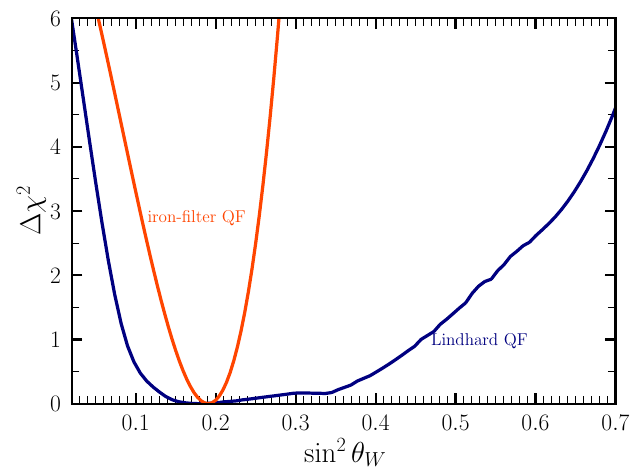
Figure 2 . ∆ χ 2 profiles for sin 2 θ W for the two QFs considered [modified Lindhard QF, eq. (3.3), and iron-filter QF as given in the ancillary files in ref. [65]]. For the modified Lindhard QF the result follows after marginalization over k and q [see eq.